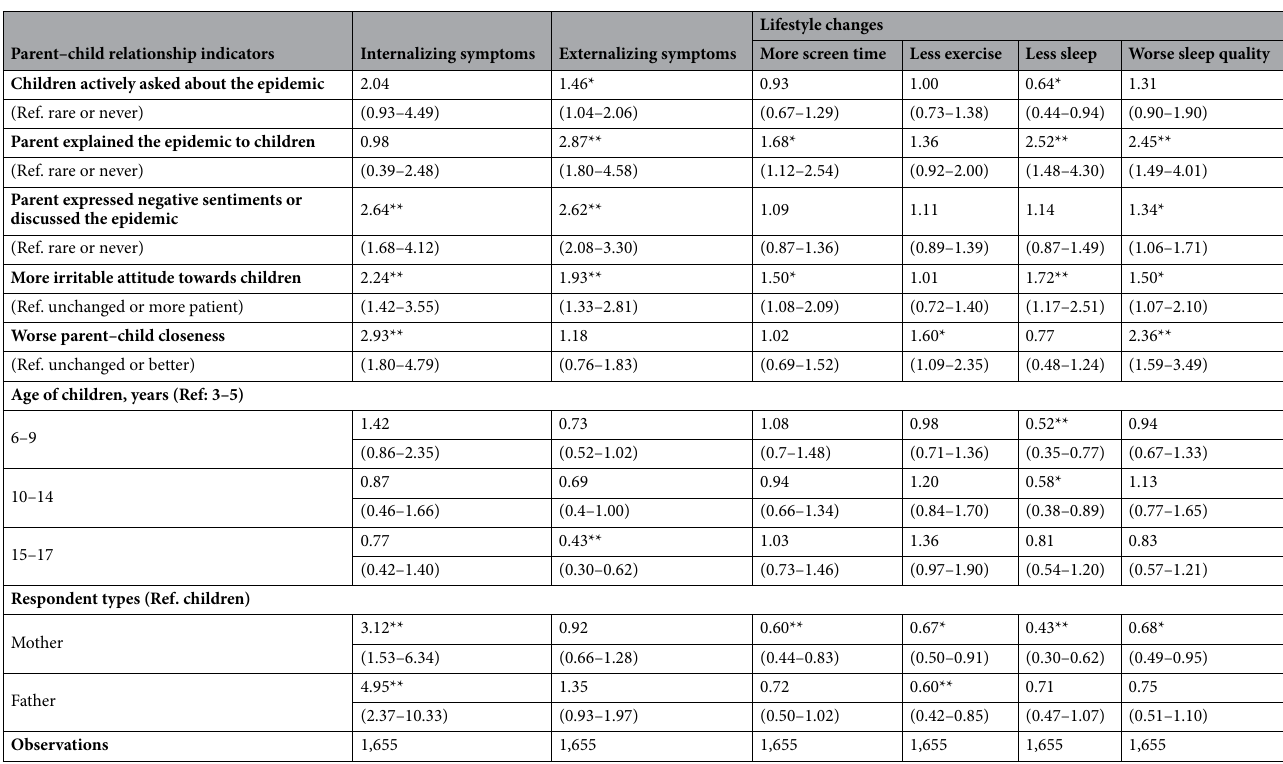
Table 4. Associations between the parent–child relationship indicators, children’s internalizing and externalizing symptoms, and lifestyle changes during the COVID-19 epidemic, multivariate logistic regression. Adjusted odds ratios with 95% confidence intervals were obtained from multivariate logistic regressions. We controlled for children characteristics (gender, age, fever symptoms or going outside during the